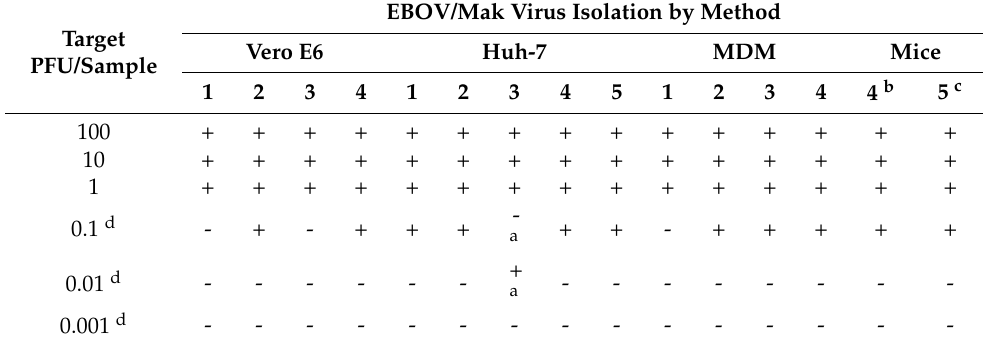
Table 2. Summary of EBOV/Mak isolation success using three cell lines and suckling BALB/c laboratory mice. Target